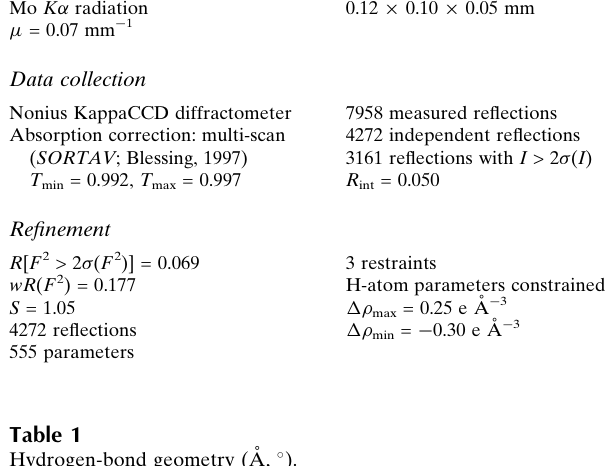
Hydrogen-bond geometry (A˚ , (cid:2)